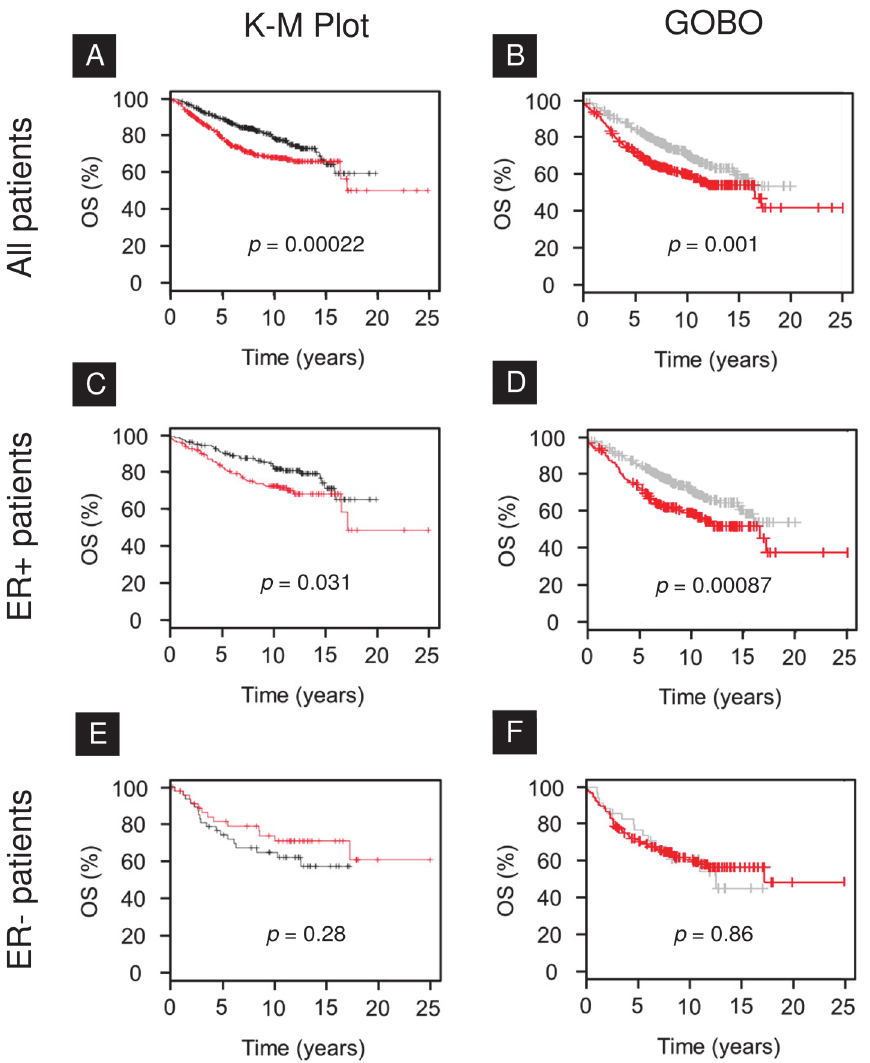
Fig 2. Overall survival in breast cancer stratified by survivin expression using two public databases. Kaplan-Meier Plotter (A,C,E) and Gene Expression-Based Outcome for Breast Cancer Online (B,D,F) data are shown. Red = high survivin expression at selected cutoff expression. A,B) High survivin expression is prognostic for poor outcome in all breast cancer patients. C,D) Likewise, high survivin expression predicts for poor outcome in patients with estrogen receptor-positive breast cancer. E,F) In patients with estrogen receptor-negative breast cancer, survivin expression is not associated with clinical outcome.